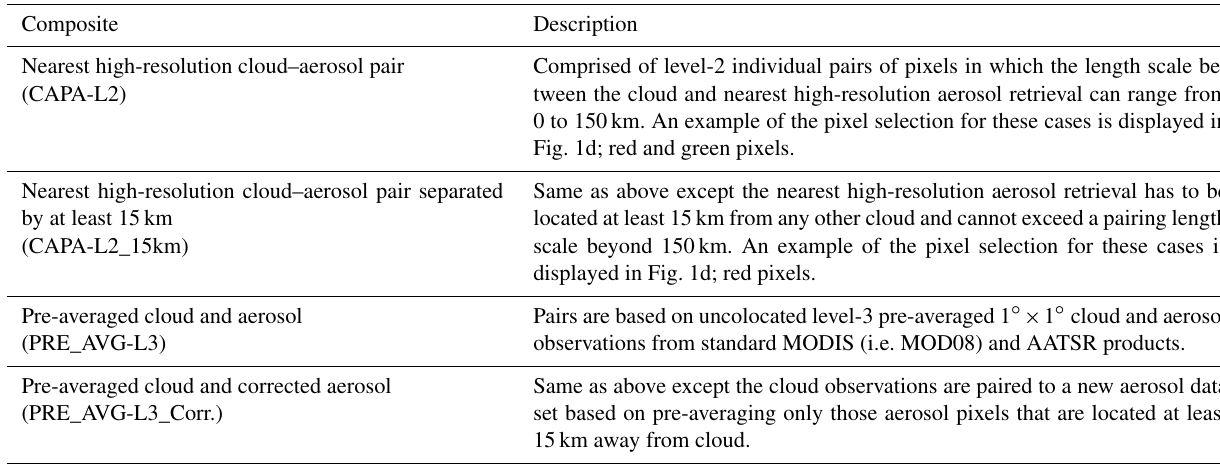
Table 1. Summary of composites used in this study